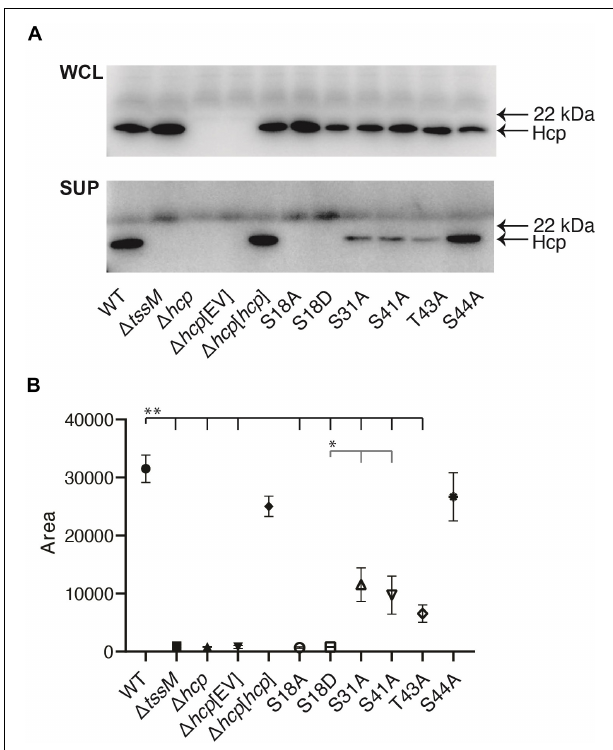
FIGURE 3 | Role of different phosphosites in Hcp secretion. Analysis of Hcp secretion by various A. baumannii AB307-0294 strains using western immunoblotting with Hcp-specific antiserum. (A) Whole-cell lysates (WCL) and secreted samples (SUP) from the wild-type AB307-0294 (WT), the (cid:49) tssm mutant, (cid:49) hcp mutant, (cid:49) hcp mutant transformed with empty vector (cid:49) hcp [EV], (cid:49) hcp mutant complemented with an intact copy of hcp ( (cid:49) hcp [ hcp ]) and the (cid:49) hcp mutant transformed with the expression constructs S18A, S18D, S31A, S41A, T43A, and S44A. The arrows at the right indicate the position of the 22 kDa MW Myoglobin Red protein (SeeBlue TM Plus2 pre-stained protein standard) and the predicted position of the Hcp protein. Images are representative of three biological replicates. Quantitative analysis of the amount of secreted Hcp protein present for each strain was determined by densitometry of triplicate biological replicate western blots (B) . Symbols represent the mean of the quantified peak area of obtained band intensity histograms for each strain ± standard deviation of the means. ∗∗ , P < 0.01, ∗ , P <